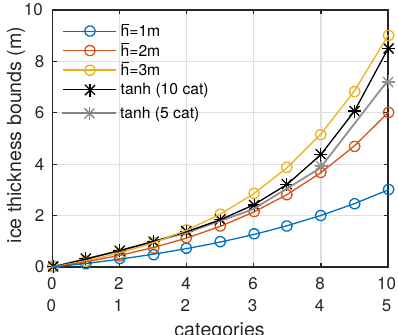
Figure 2. Thickness category boundaries (m) as a function of cate- gories (5 or 10). The tanh formulation from CICE, which is used in the former version 3.0 of LIM, is represented in grey and black for 5 and 10 categories, respectively. The formulation used in the new version 3.6 of LIM is proportional to ( 1 + h) − α , where α = 0 . 05, and does not depend on the number of categories. It is displayed above for three different mean ice thicknesses h (1, 2 and 3m), h = 2m being the closest to the tanh